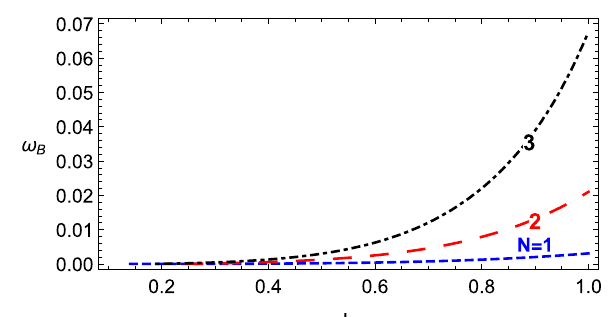
Fig. 12 DependenceoftheISCOradiusofchargedparticleonthemag- netic coupling parameter ω B and conformal parameter L for different values of the parameter N . Units in which M = 1